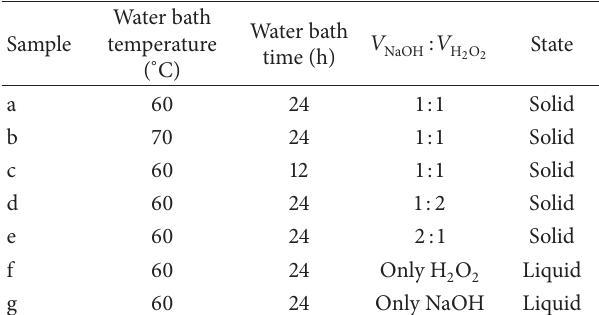
Table 1: Samples prepared on different